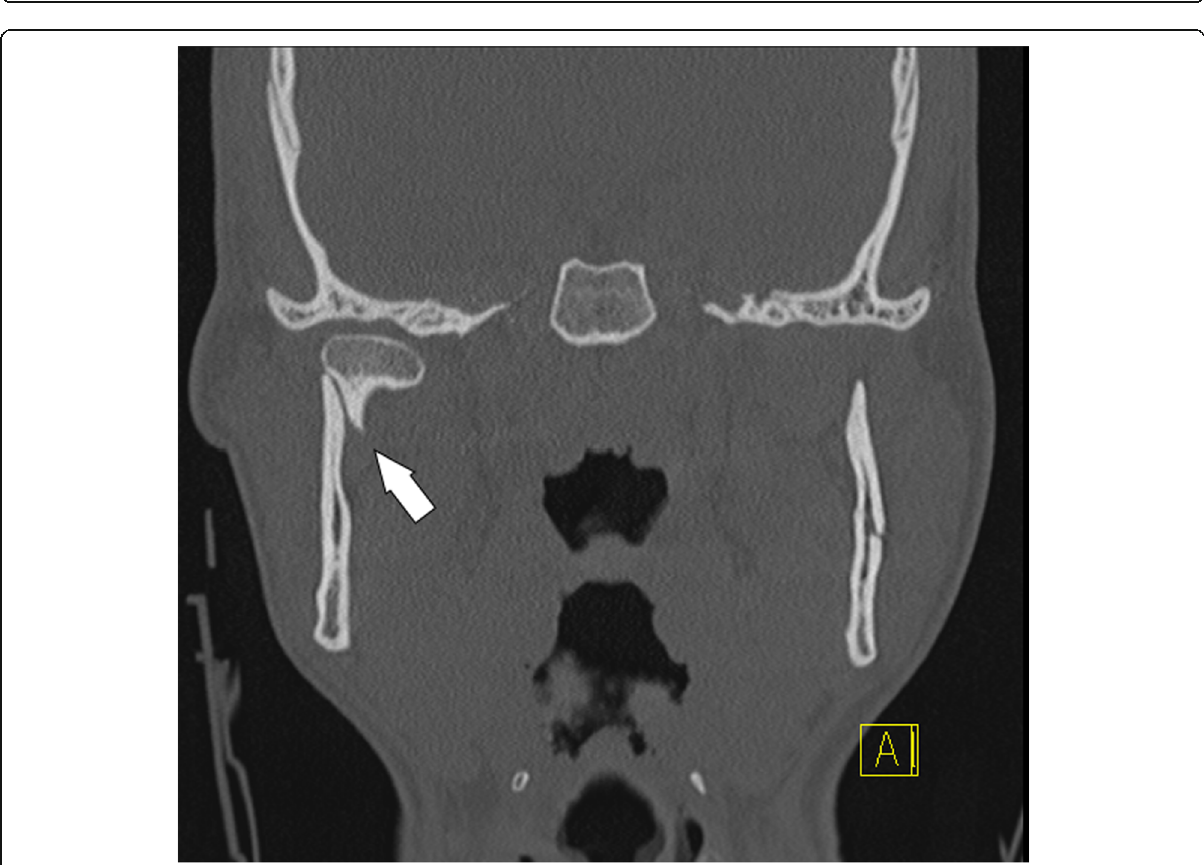
Fig. 14 Condylar process fracture. No deviation. a Cropped panoramic radiograph. b 3D computed tomography reformation of the same patient. The bone fragments are in line and close to each other (arrows)